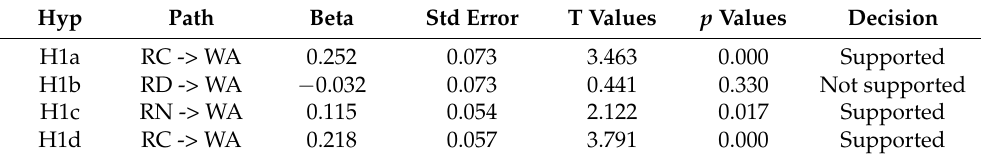
Table 9. Direct Hypotheses Results.